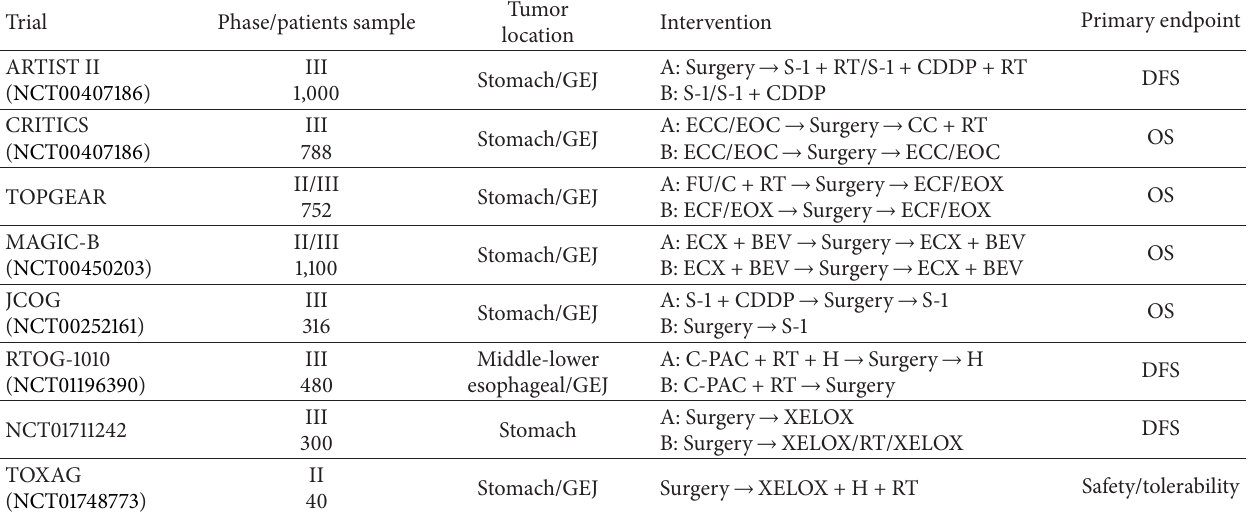
Table 2: Ongoing trials in the adjuvant therapy setting for gastric